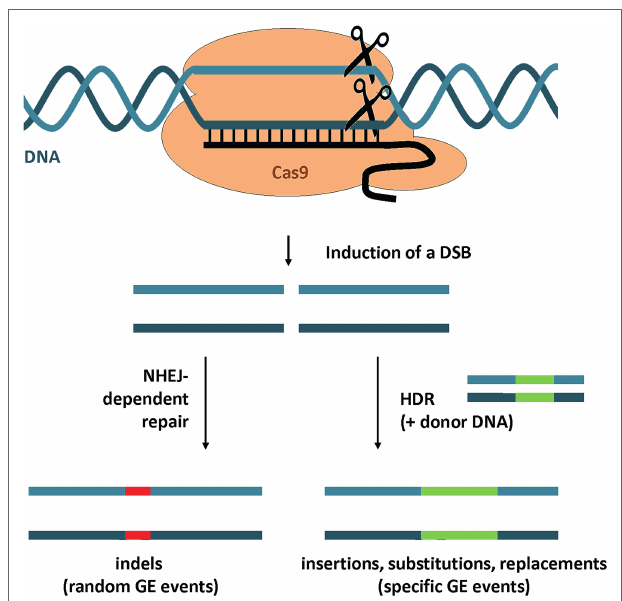
FIGURE 2 | GE strategies using CRISPR/Cas9. A DSB in the target locus is introduced by CRISPR/Cas9-mediated DNA cleavage. The DSB repair by NHEJ leads to random mutations at the site of the DNA break including insertions and deletions (indels). By the addition of a homologous donor DNA, the DSB can be repaired by HDR. This strategy can be used to introduce specific GE events such as insertions, substitutions or gene